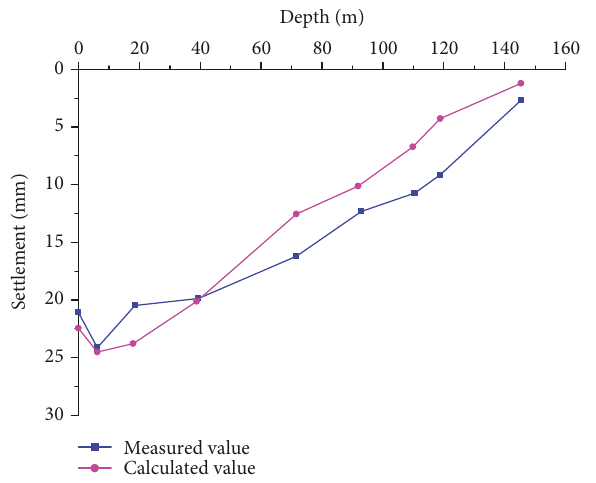
Figure 8: Comparison between measured and calculated settlements at di ff erent depths in year 2000. Table 4: Ground settlement under di ff erent groundwater levels. Type of